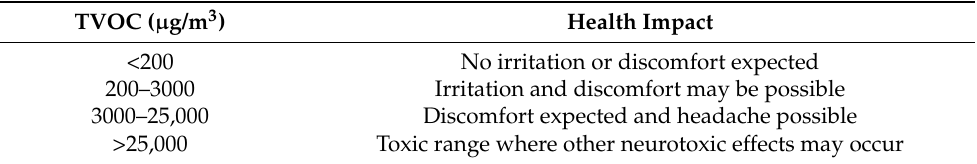
Table 1. Impact of TVOC